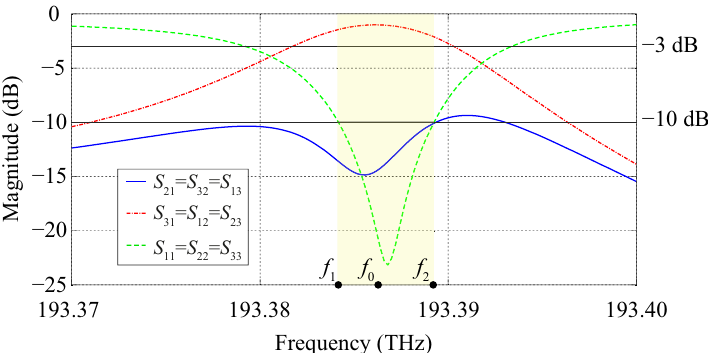
Figure 10. Frequency response obtained from 3D simulations performed with CST Studio Suite.